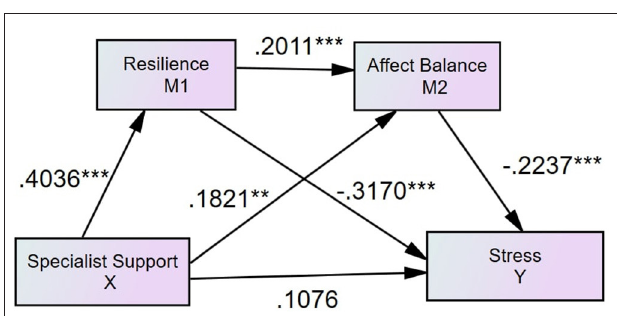
FIGURE 4 | Standardized structural model (specialist support, N = 339, R 2 = 0.2188). *** p < 0.001, ** p <